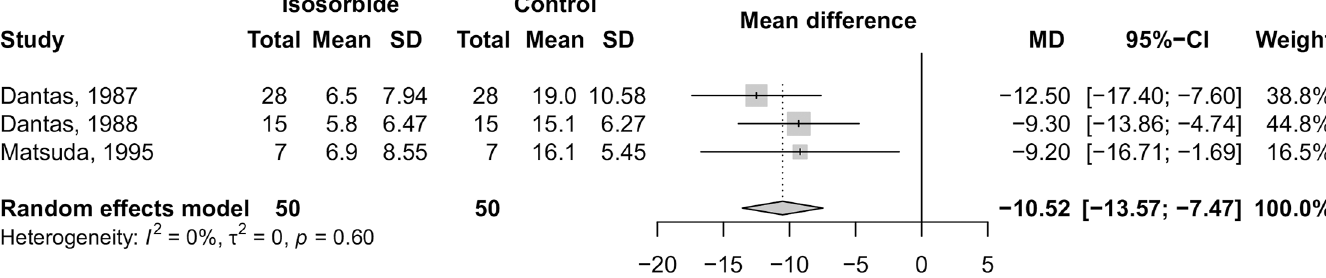
Fig 2. Effect of isosorbide on lower esophageal sphincter pressure 10 minutes after administration.